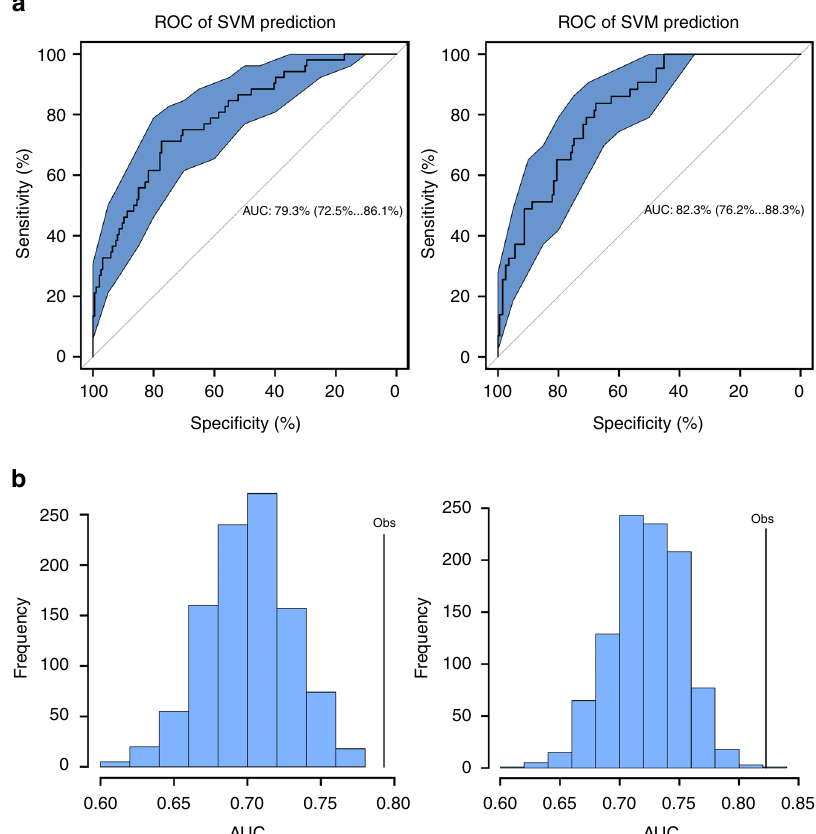
Fig. 5 A machine learning prediction of a penal of CpG sites on HIV frailty. a Prediction of 748 CpG sites on HIV frailty using a support vector machine (SVM) in the discovery sample. A set of 748 CpG sites was selected from epigenome-wide association analysis in 386 samples that was treated as a training set. A different set of samples ( N = 238) selected from the same cohort was used as a test set. Receiver-operating characteristic (ROC) analysis shows the prediction of HIV frailty in 284 test samples. Left: area under the curve of the prediction of high HIV frailty (Veteran Aging Cohort Index, VACS index > 50); right: area under the curve of the prediction of low HIV frailty (VACS index < 16). b Permutation test (1000) of support vector machine- learning prediction for HIV high frailty (left) and low frailty